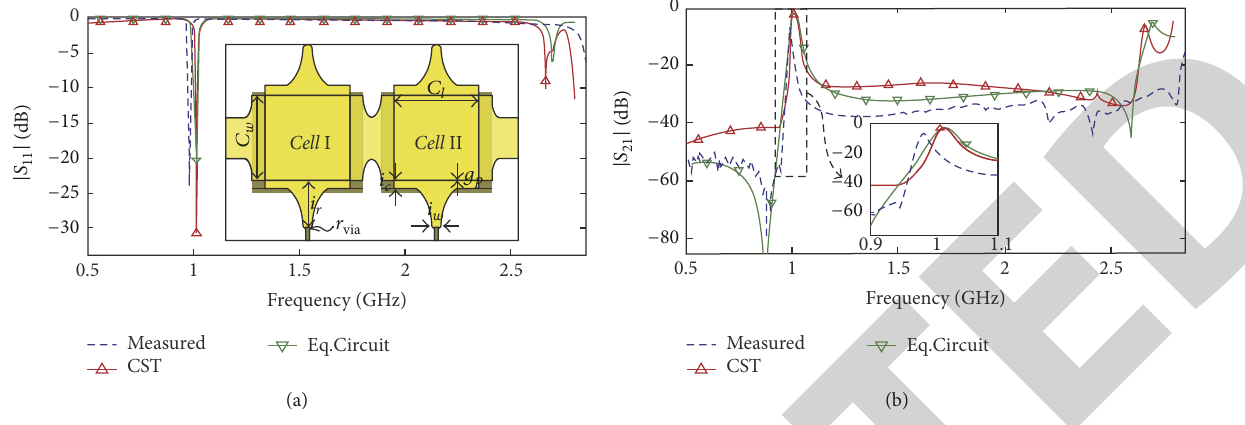
Figure 7: Measured, full-wave, and equivalent circuit simulations of (a) |𝑆 11 | and (b) |𝑆 21 | . Layout parameters are 𝑖 𝑟 = 6.5mm, 𝑖 𝑐 = 1 mm, 𝑖 𝑤 = 1mm, 𝑟 via = 0.25 mm, and 𝑔 𝑝 = 0.2 mm. Extracted values of circuit model elements are 𝐿 stub = 10.8 nH and 𝐶 stub = 0.35